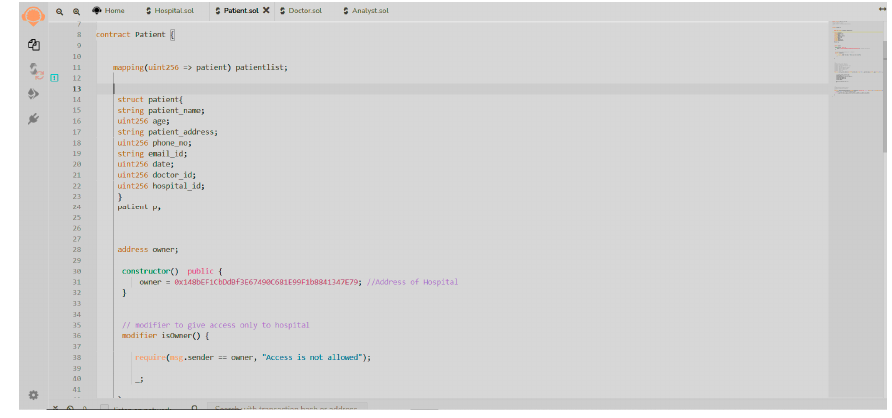
Figure 10. Patient implementation using Solidity.